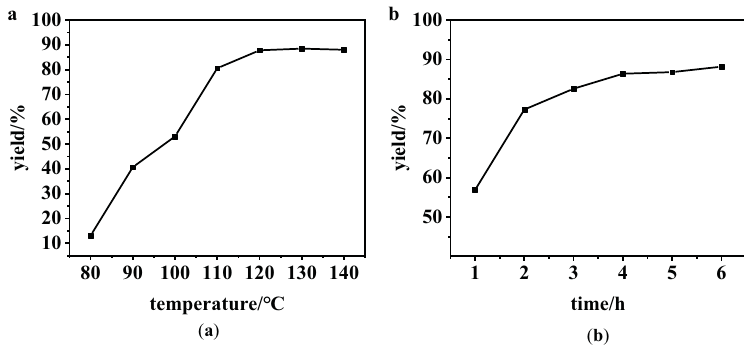
Figure 5: ( a ) E ff ect of reaction time and ( b ) reaction temperature on FA.